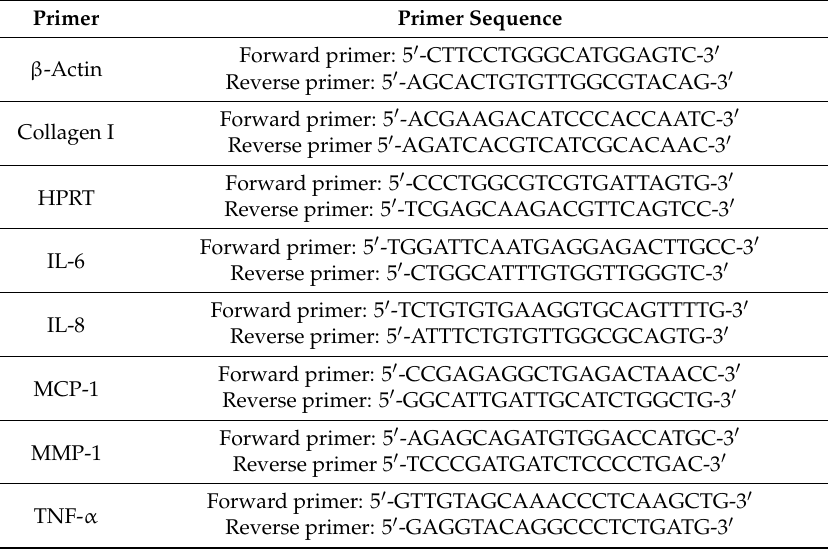
Table 3. Primers and Primer sequences used for gene expression